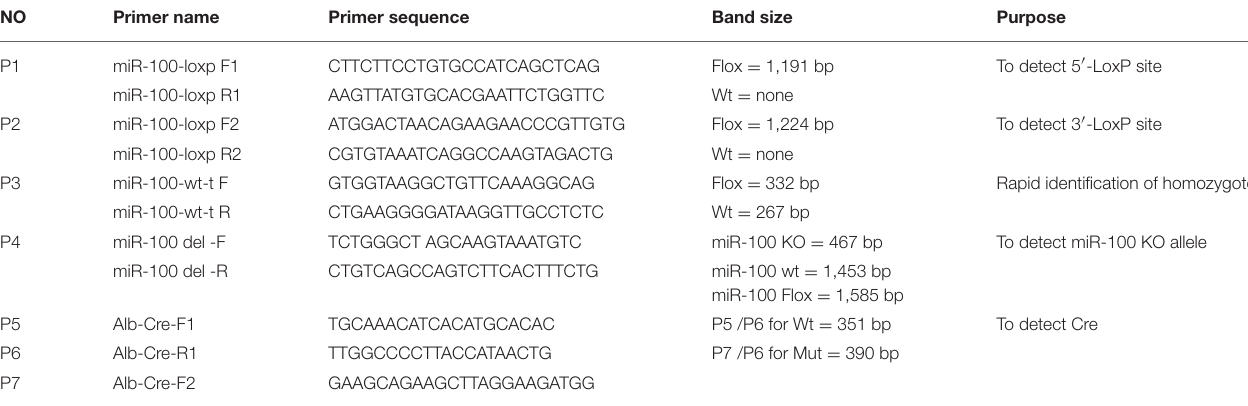
TABLE 1 | Primers sequences of PCR used in this